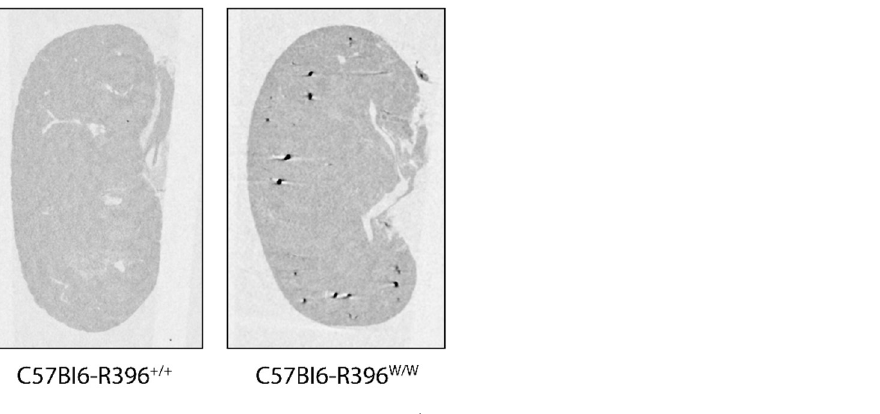
Figure 3. Nephrolithiasis in C57Bl6-R396 w/w mutant pups. Kidneys were harvested at P7 and imaged by microCT.